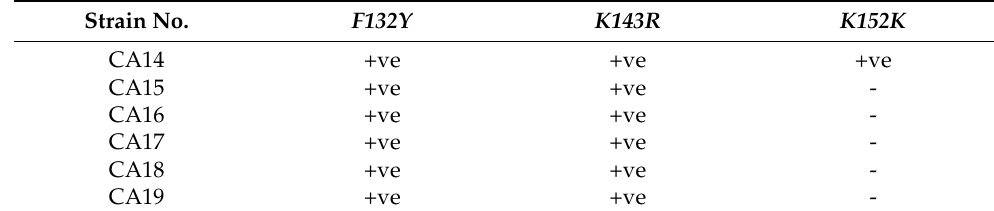
- negative; +ve positive for mutation.